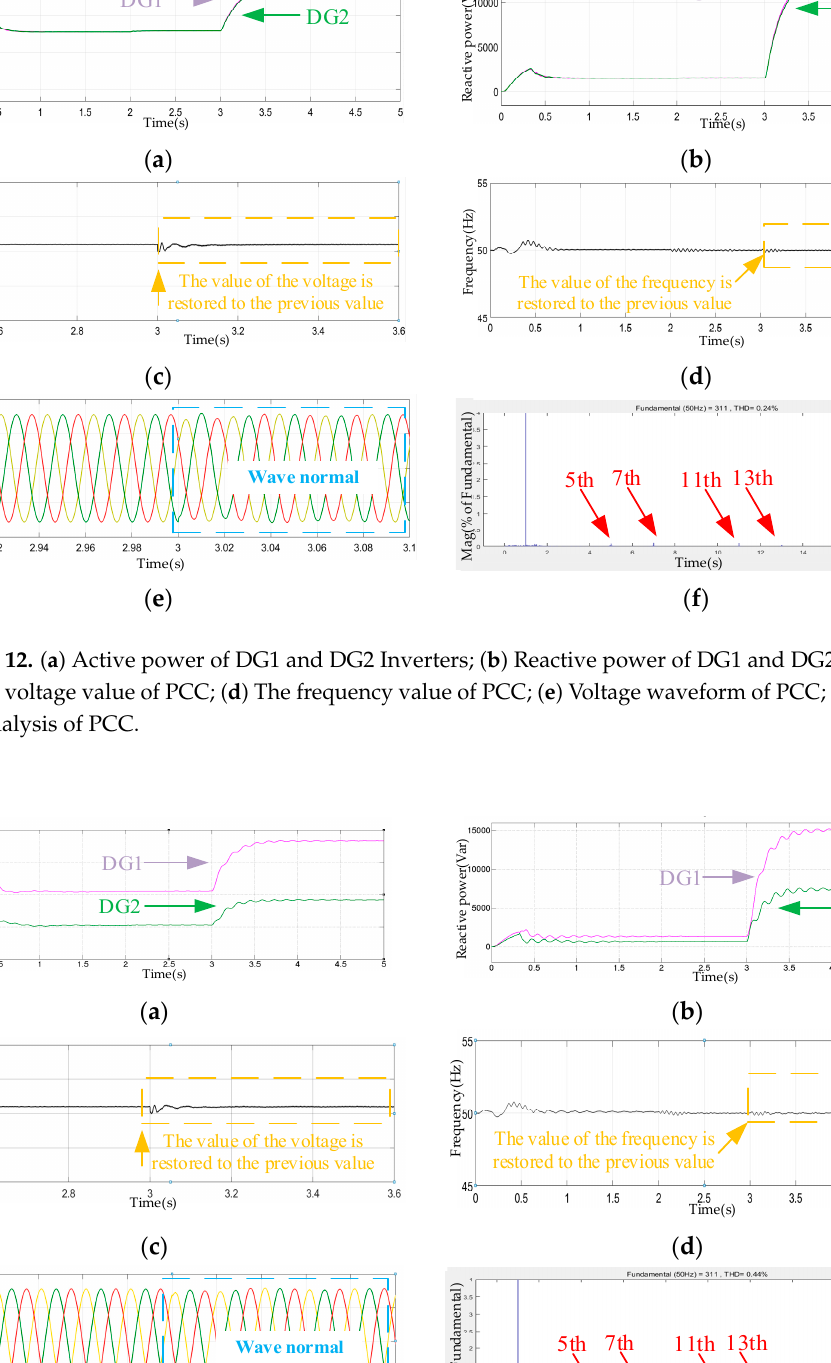
( f ) Figure 11. ( a ) Active power of DG1 and DG2 Inverters; ( b ) Reactive power of DG1 and DG2 Inverters; ( c ) The voltage value of PCC; ( d ) The frequency value of PCC; ( e ) Voltage waveform of PCC; ( f ) Voltage FFT analysis of PCC. From Figure 11a,b, the active powers of two inverters can be accurately distributed while the reactive powers cannot. The difference of reactive power between DG1 and DG2 is 7000 Var. In Figure 11c,d, the voltage and frequency fluctuate when the load changes. The values of voltage and